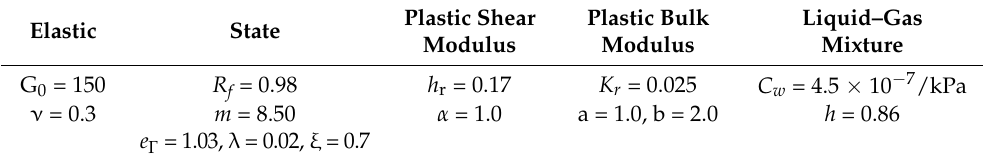
Table 1. Model parameters.